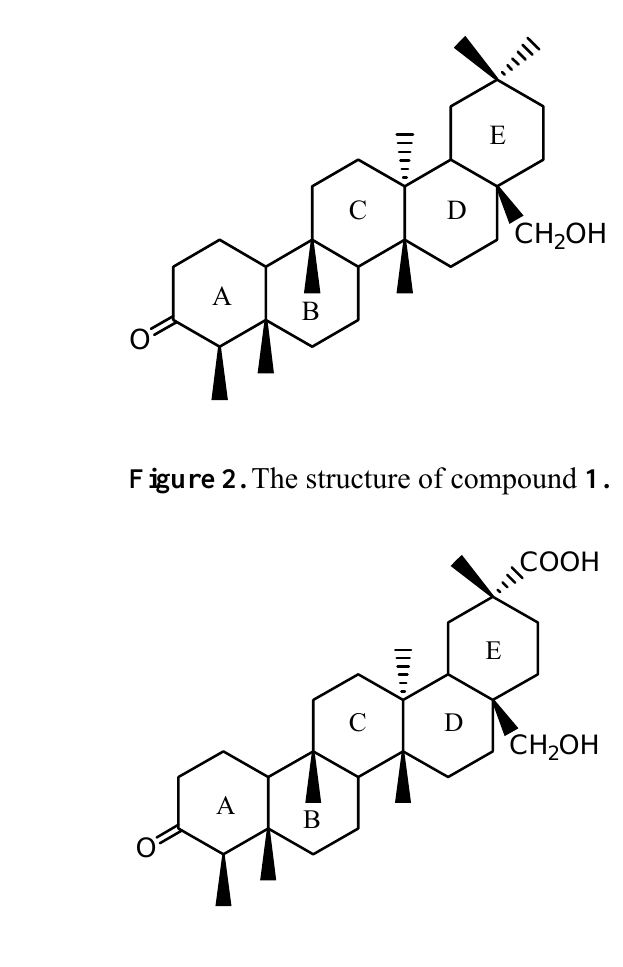
Figure 1. The structure of 28-hydroxy-friedelan-3-one.